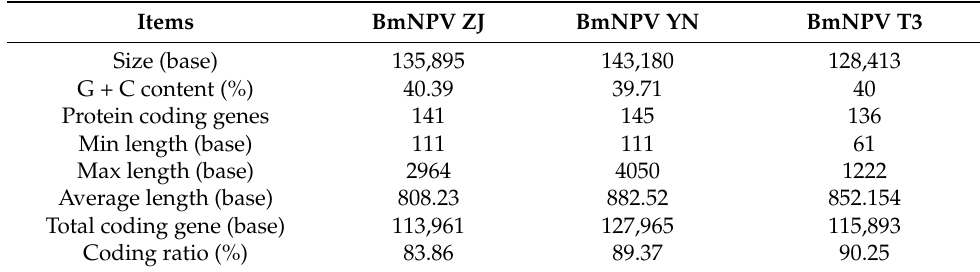
Table 4. General features of BmNPV genomes.